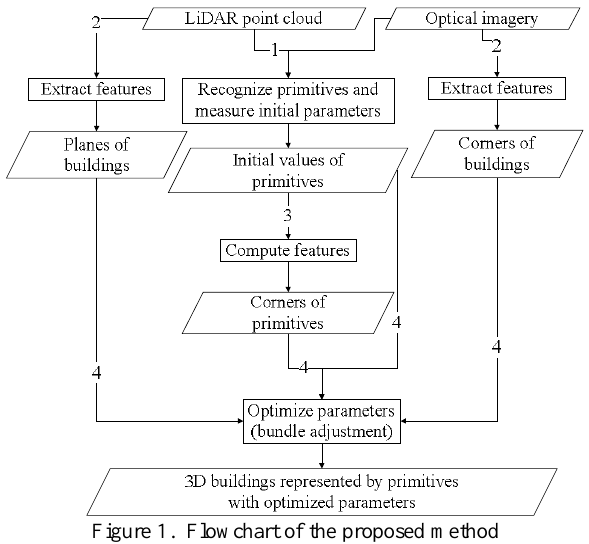
Figure 1. Flowchart of the proposed method 1. Recognize primitives and measure initial parameters. With the help of optical imagery and LiDAR point cloud, the building is decomposed into are measured roughly on LiDAR point cloud